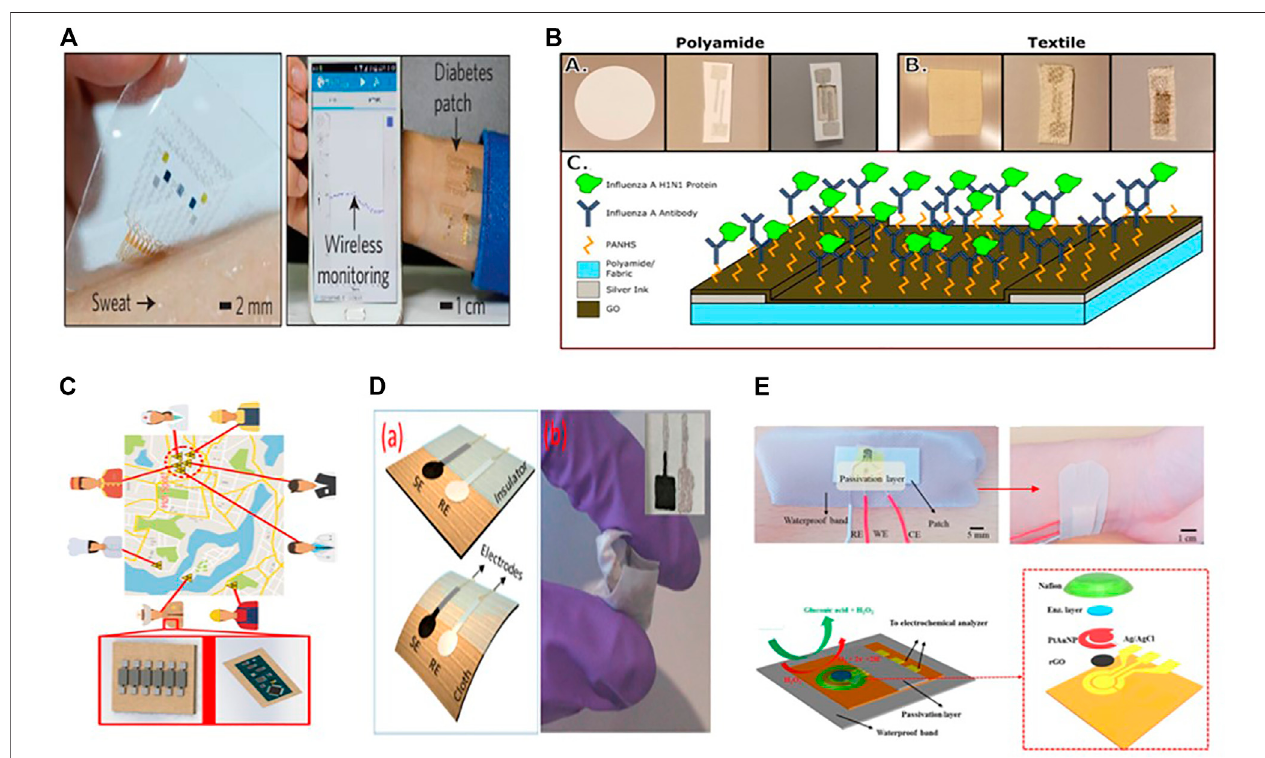
FIGURE 3 | (A) An optical image of a graphene-based hybrid electrochemical device mounted on human skin for automatic diabetes monitoring (Copyright 2016; Nature Technology). (B) A screen-printed graphene oxide-based biosensor using graphene oxide transduction fi lm on both nanoporous polyamide and textiles substrates for tracking environmental exposure to in fl uenza a virus (Copyright 2018; Electrochemical Society). (C) Schematic diagram of environmental exposure to in fl uenza a virus (Copyright 2018; Electrochemical Society). (D) A lightweight potentiometric pH sensor, SE-sensitive electrode, and reference electrode are schematically represented on cloth (Copyright 2019; Biosensor). (E) Photographs and schematic representation of the completed sweat-based glucose biosensor mounted on human skin (Copyright 2018; Biosensors and